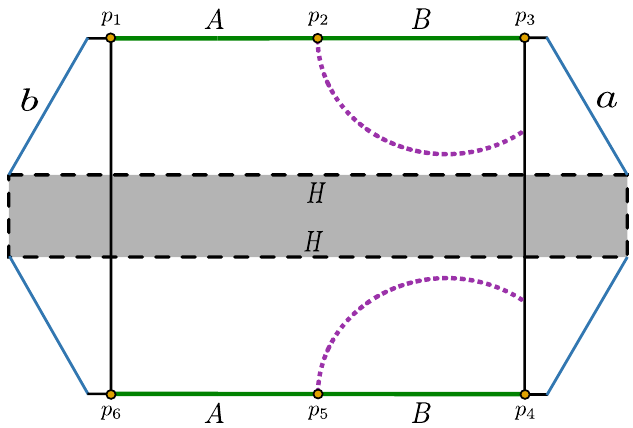
Figure 15 . The points in the two BCFT 2 copies are identified similarly as in the figure